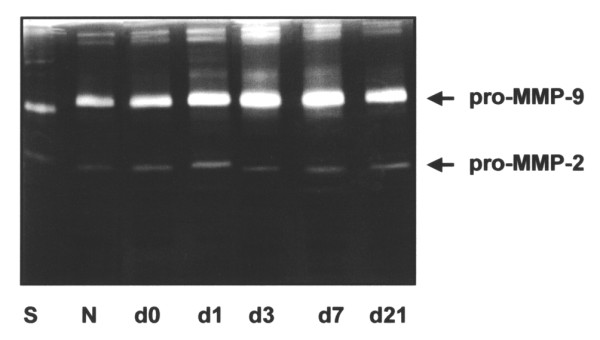
Detection, by gelatin zymography, of pro-matrix metalloproteinase-2 (pro-MMP-2) and pro-MMP-9 expression in joint extracts at different time points after the induction of antigen-induced arthritis. Joint extracts were prepared at days 0, 1, 3, 7 and 21 and from normal mice (N) (three individual animals per day). The protein concentration was determined by bicinchoninic acid protein assay, and equal amounts of protein were applied to each lane. The zymography was developed and stained as described in Materials and Methods. The picture shows a representative gel of three comparable experiments. S, standard (human pro-MMP-2, [72 kDa] and pro-MMP-9 [92 kDa]).